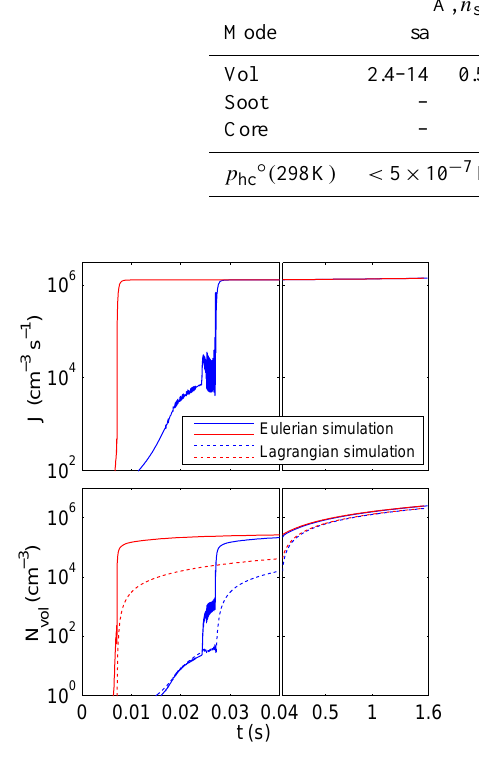
Figure 12. Nucleation rate and particle concentration as a function of time on the path lines. Nucleation rate profiles are the same in both simulations. Note the different timescales; the left plots show the very beginning of the curves as zoomed.